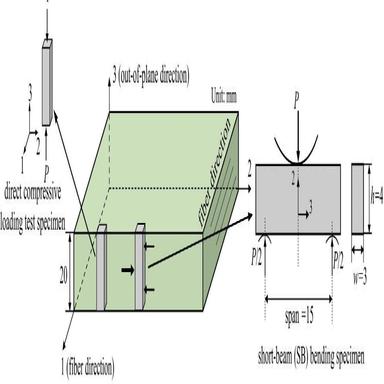
The short-beam bending specimen loaded on the 2–3 principal material plane and the direct compressive loading test specimen.